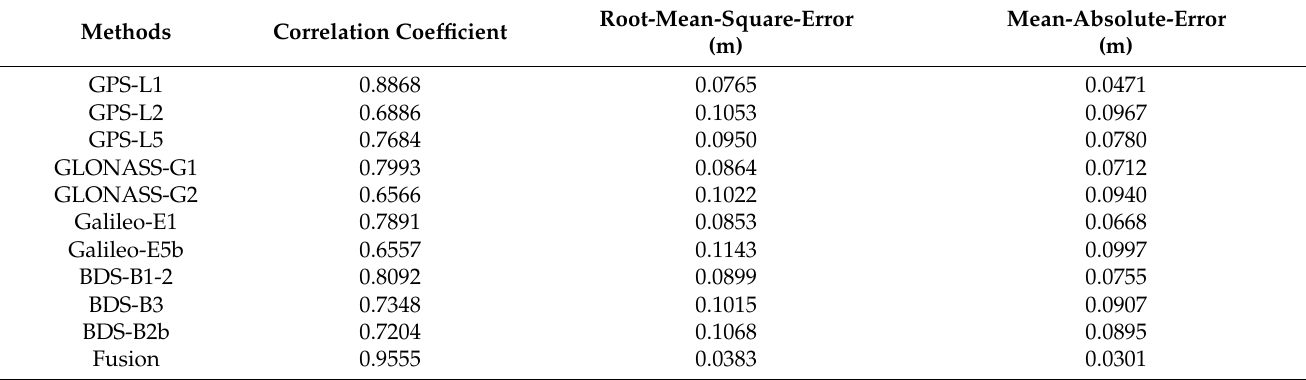
Table 3. Wheat height retrieval precision statistics.